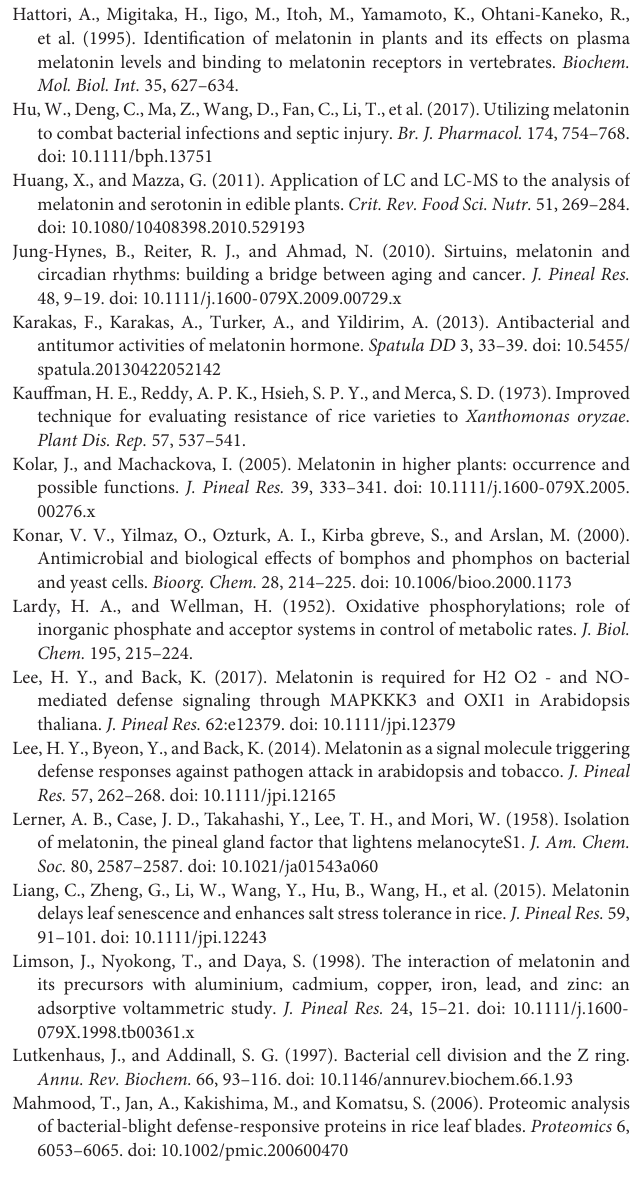
FIGURE S1 | The hypersensitive reaction triggered by Xoo on tobacco leaves pretreated with melatonin. The tobacco leaves were inoculated with different concentrations of Xoo (ddH 2 O, OD 600 = 0.2, 0.4, 0.8). (a) Tobacco leaves without the melatonin treatment and (b) tobacco leaves pretreated with 200 µ g/mL melatonin for 12 h. FIGURE S2 | Effects of exogenous melatonin on the pathogenicity of PXO99 and the hypersensitive response. (A) Phenotype of rice leaves inoculated with PXO99 treated with melatonin (200 µ g/mL). (B) Lesion length on rice leaves inoculated with PXO99 treated with melatonin (200 µ g/mL). (C) Bacterial population in rice leaves inoculated with PXO99 treated with melatonin (200 µ g/mL). Bar = 2 cm. FIGURE S3 | The hypersensitive reaction of tobacco leaves triggered by Xoo pretreated with melatonin. Xoo cells were pretreated with melatonin (200 µ g/mL) for 24 h. (A) The tobacco leaves inoculated with ddH 2 O, Xoo without melatonin treatment, Xoo pretreated with melatonin (200 µ g/mL). (B) The mRNA expression of HrpD6 in response to the melatonin